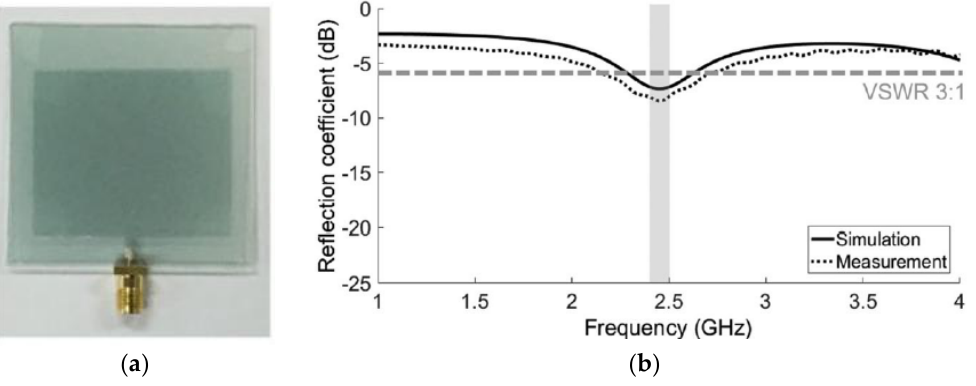
Figure 5. ( a ) Fabricated microstrip patch antenna and ( b ) simulated and measured reflection coefficients of the proposed antenna [20]. (With permission from IEEE)